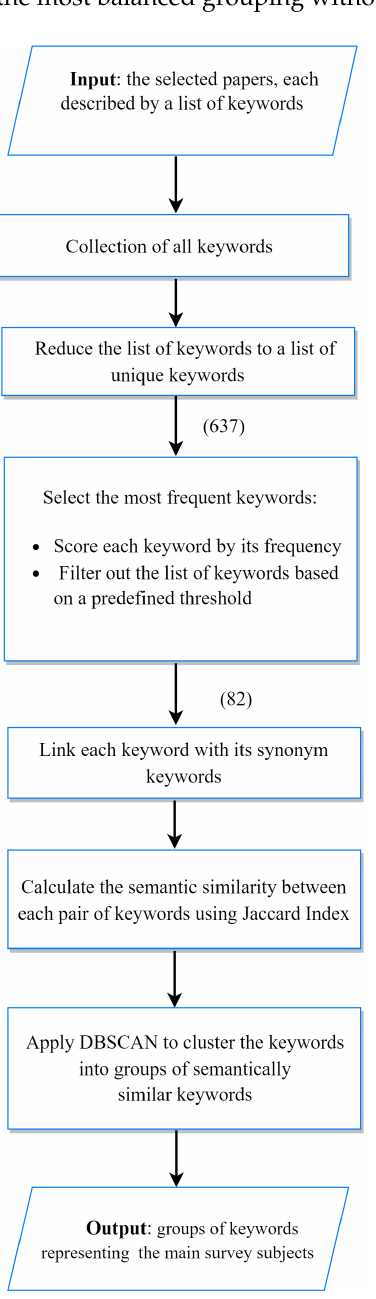
Figure 7. Flowchart describing the different steps of the semantic-aware approach applied to identify the main subjects covered by the included